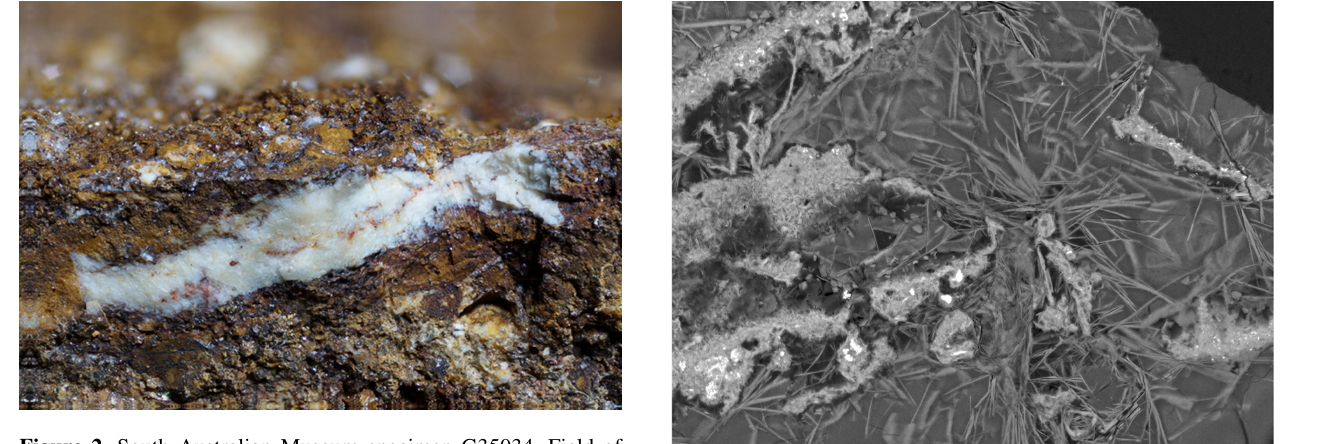
Figure 2. South Australian Museum specimen G35034. Field of view is 7mm across. Photograph: Peter Elliott.